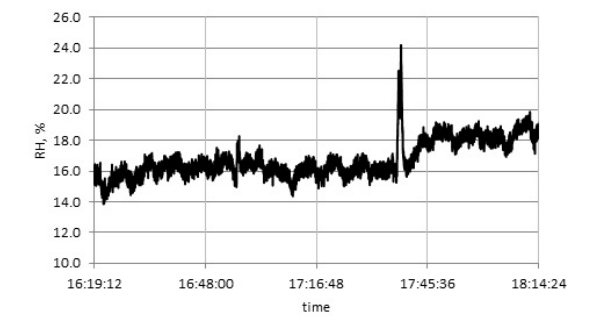
Figure 8: Relative humidity of the air in the exhaust duct.